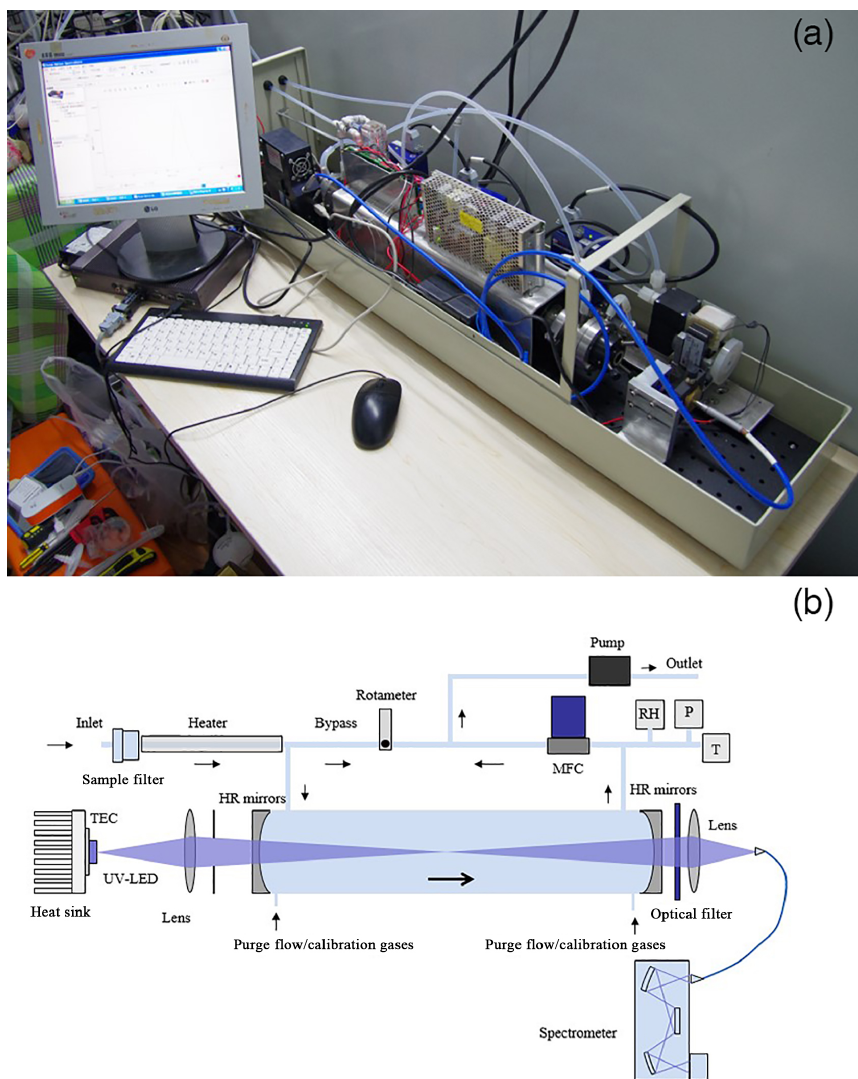
Figure 1. (a) Photograph of the IBBCEAS instrument (the case was removed for this picture to show the structure of the IBBCEAS instru- ment); (b) schematic of the IBBCEAS